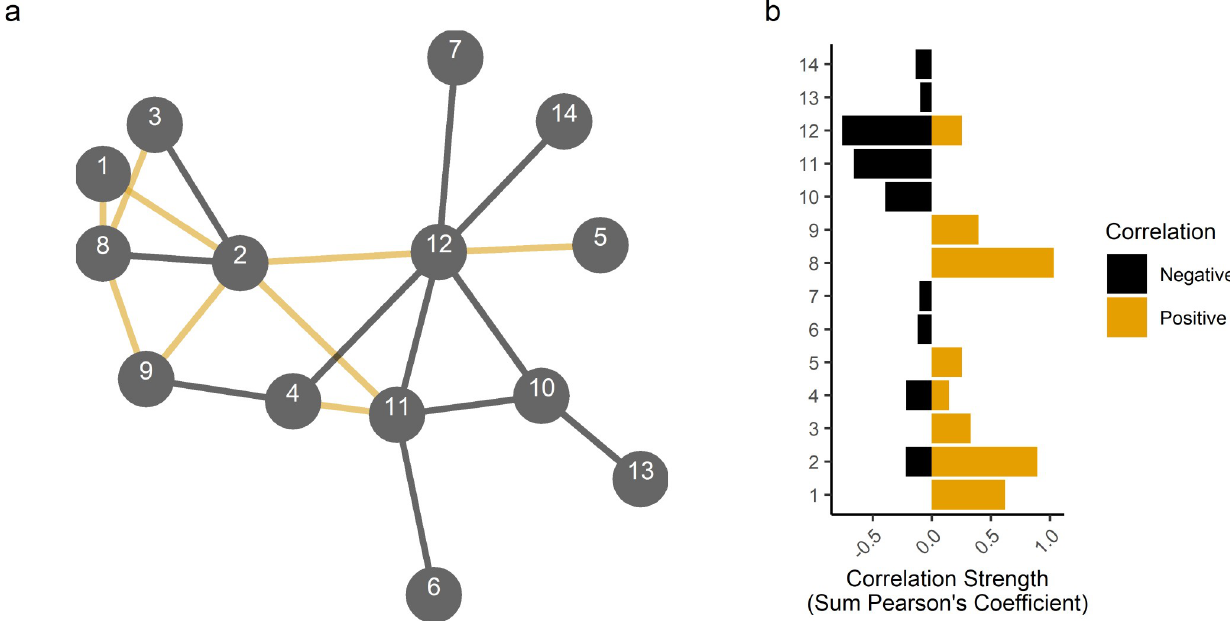
Fig 2. Interspecific interactions inferred from relative abundance correlations. a, Interaction network with positive associations denoted by black edges and negative associations denoted by orange edges. Species included had a study-wide average relative abundance greater than 5% and had at least one correlation greater than or equal to r = 0.10. b, Barplot of summed positive and negative correlations for each species. Species key b: 1) Anaerococcus hydrogenalis , 2) Anaerococcus lactolyticus , 3) Anaerococcus prevotii , 4) Anaerococcus vaginalis , 5) Corynebacterium tuberculostearicum , 6) Finegoldia magna , 7) Fusobacterium nucleatum , 8) Peptoniphilus harei , 9) Porphyromonas levii , 10) Pseudomonas aeruginosa , 11) Staphylococcus aureus , 12) Staphylococcus epidermidis , 13) Staphylococcus lugdunensis , 14) Streptococcus agalactiae .